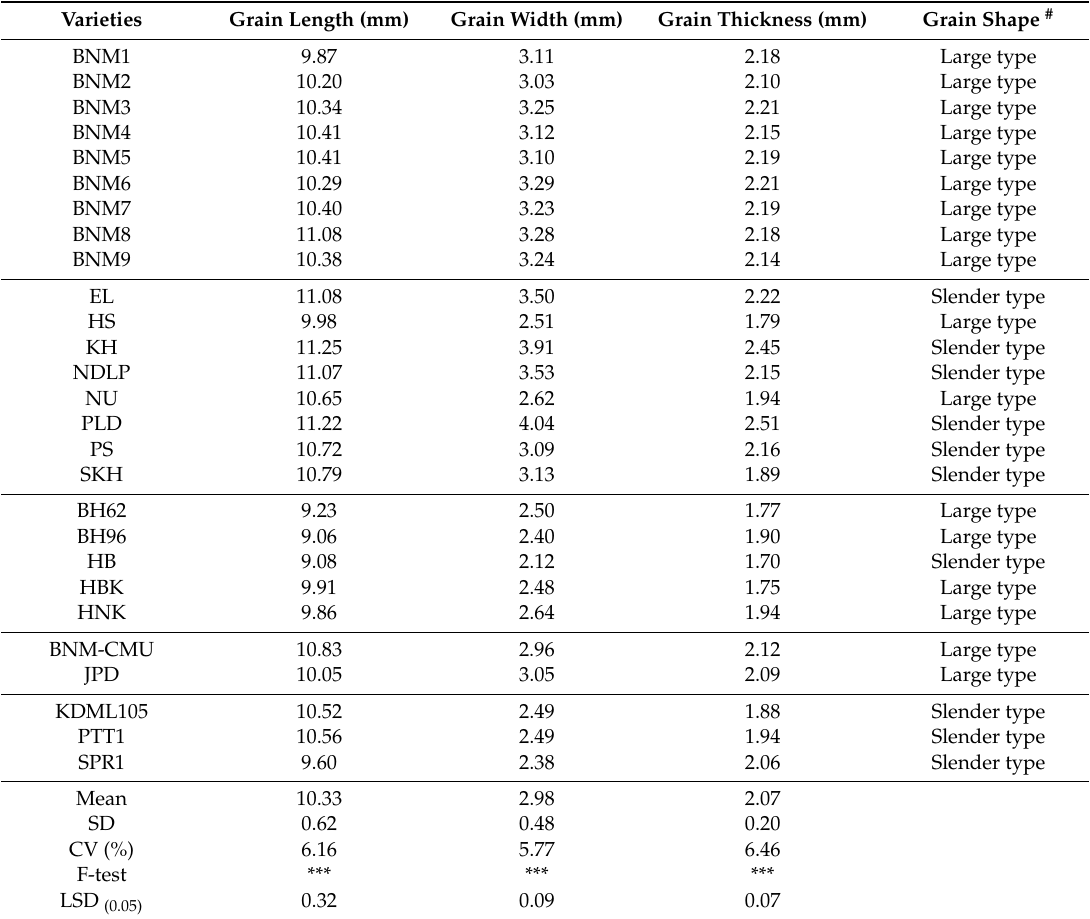
Table 2. Grain size and shape of paddy rice of 22 fragrant rice landrace accessions, 2 breeding lines, and 3 elite variety